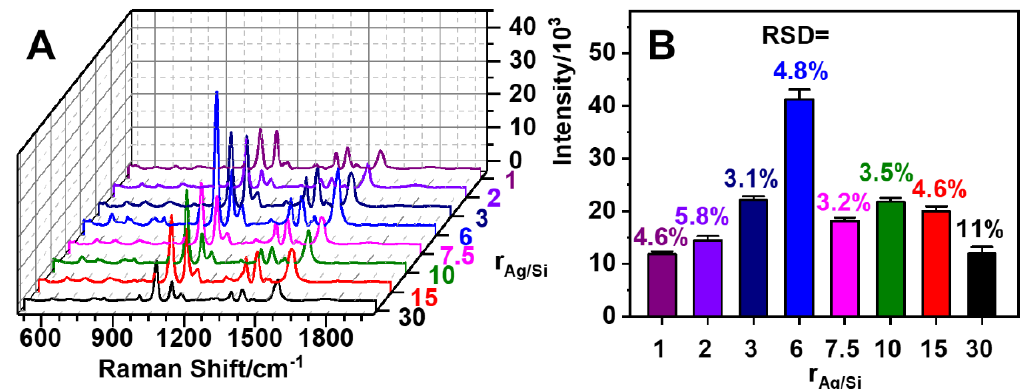
Figure 2. Effect of the weight ratio of AgNO 3 /SiO 2 on ( A ) Raman signals and ( B ) signal intensity at 1078 cm − 1 for pATP on SiO 2 @nAg. The Raman spectra were acquired at 1.0 × 10 − 4 M pATP using a 785-nm laser at 4.0 mW output power for 6 s. Each spectrum in Figure A was averaged over 15 random measurements from triplicate experiments.